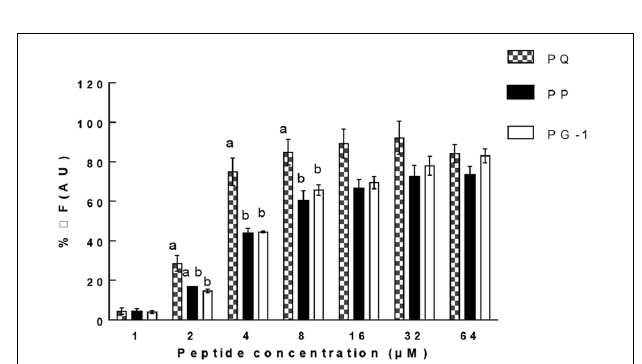
FIGURE 8 | Percent leakage of the dye calcein from negatively charged LUVs in the presence of the peptides. The graphs were derived from average of three independent trials. Means in the same concentration with different superscript indicate a very significant difference ( P < 0.01).